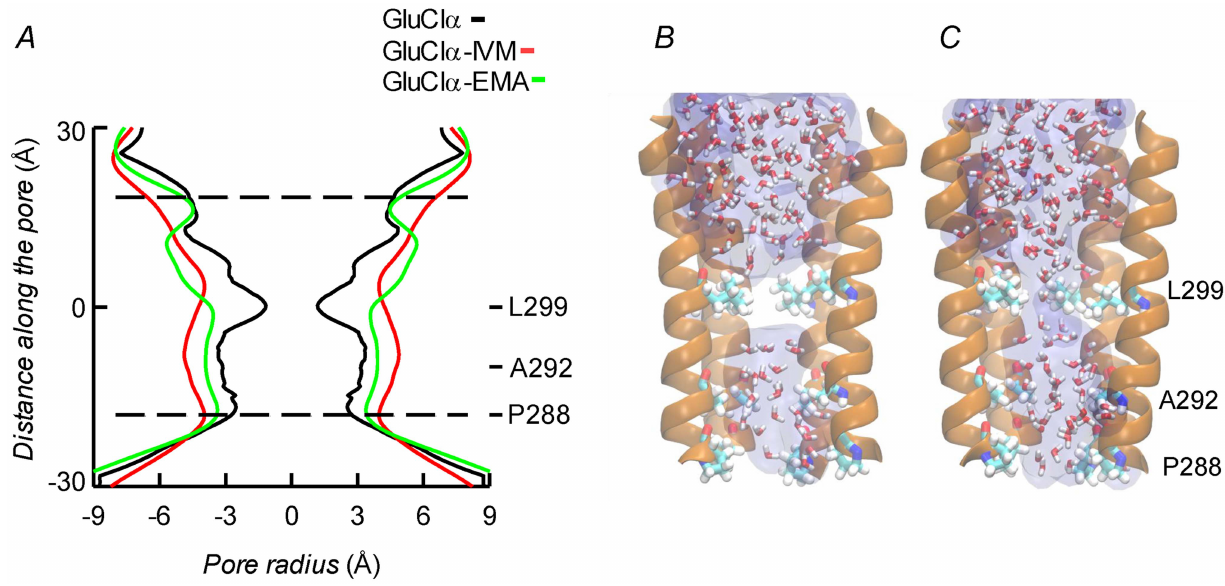
Figure 8. A. Channel pore radius along the z-axis in the receptor alone (black) and in the CrGluCl a -emamectin (green) and CrGluCl a -ivermectin (red) systems. A length, mainly intramembrane, of the pore is shown. The discontinuous lines show the pore segment lined by M2 a -helices. Values have been taken at the end of MD trajectories. B and C. Lateral views of the pore at time zero (C) and at the end (B) of the MD trajectory for CrGluCl a in absence of drugs. Only four M2 helices are shown with the fifth removed for clarity. Residues P288, A292 and L299 are shown in licorice. Water occupancy is shown as licorice and surface.